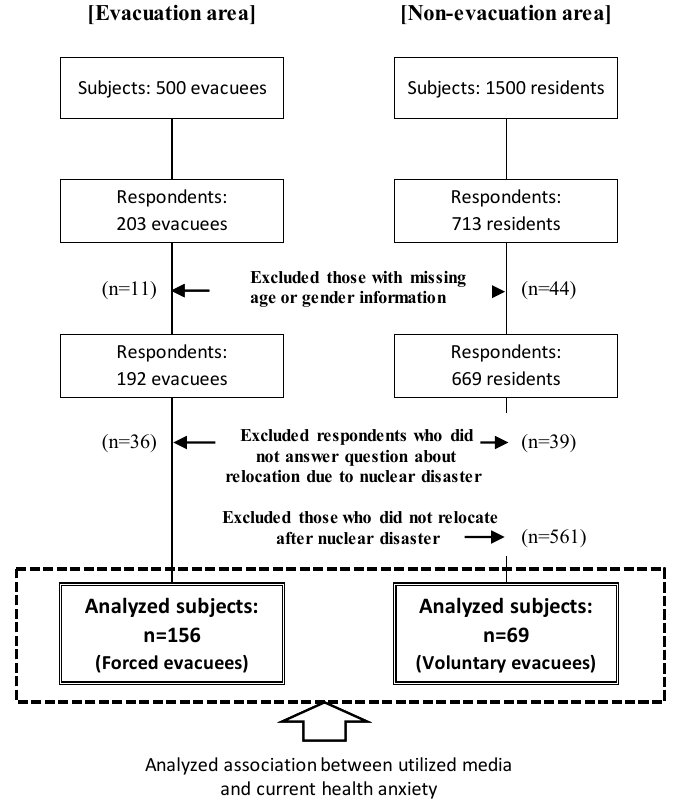
Figure 2. Sample selection in the evacuation and non-evacuation areas. The analyzed subjects included 156 forced evacuees and 69 voluntary evacuees.